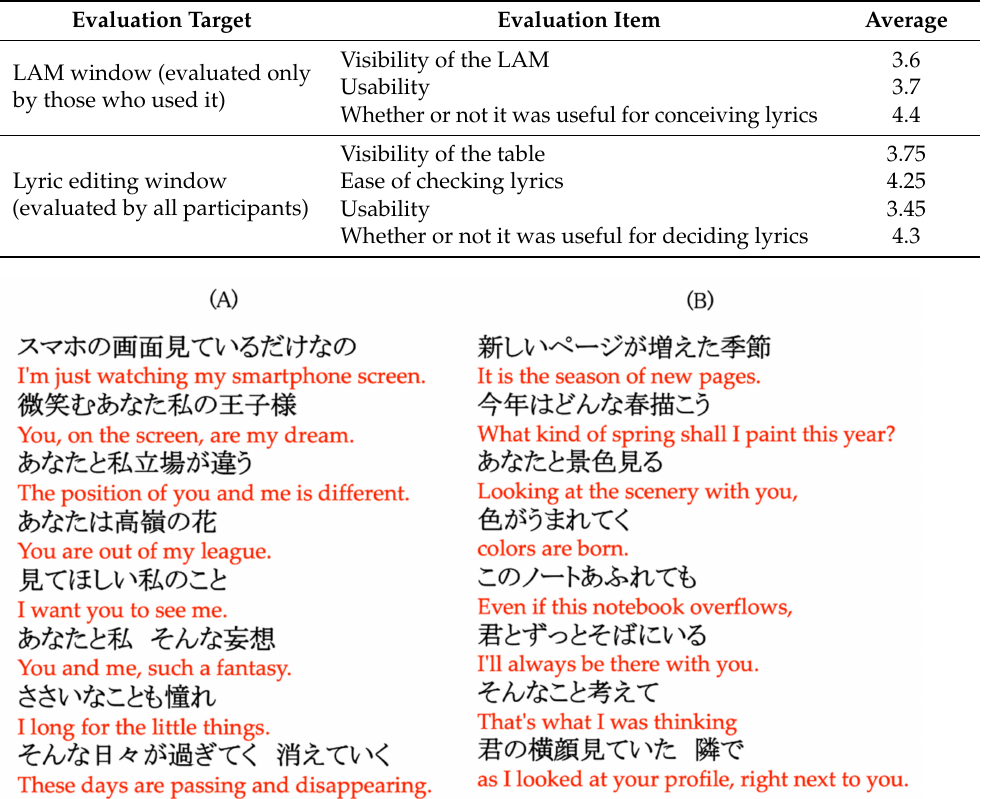
Table 6. Results of the subjective evaluation of lyric-writing functions.